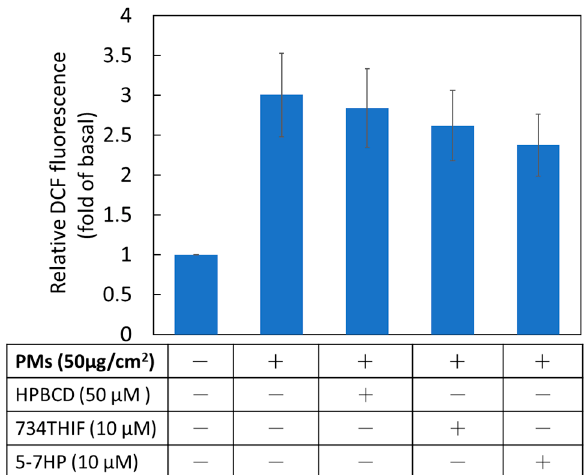
Figure 9. The effect of HPBCD, raw 734THIF and 5-7HP on PM-induced ROS generation in human keratinocytes. All samples (10 μ M) were dissolved in DMEM solution ( n = 6 in each group).